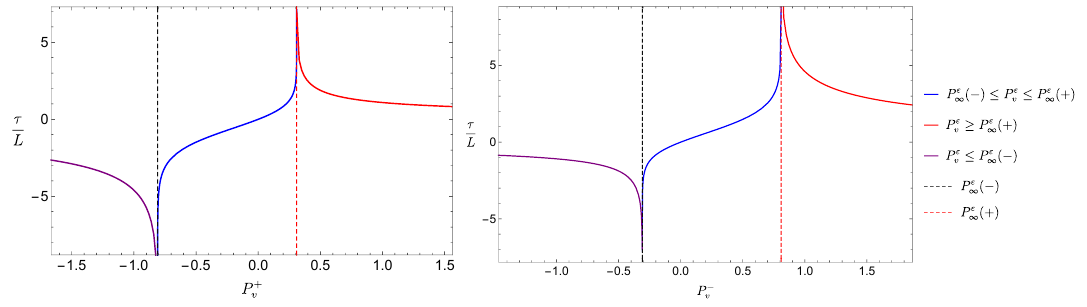
Figure 5 . The relation between the boundary time τ and the conserved momentum P ε = 1 = α , x = 1 and d = 2 in both panels and ε = + , − for the left and right plot, respectively. α ± B